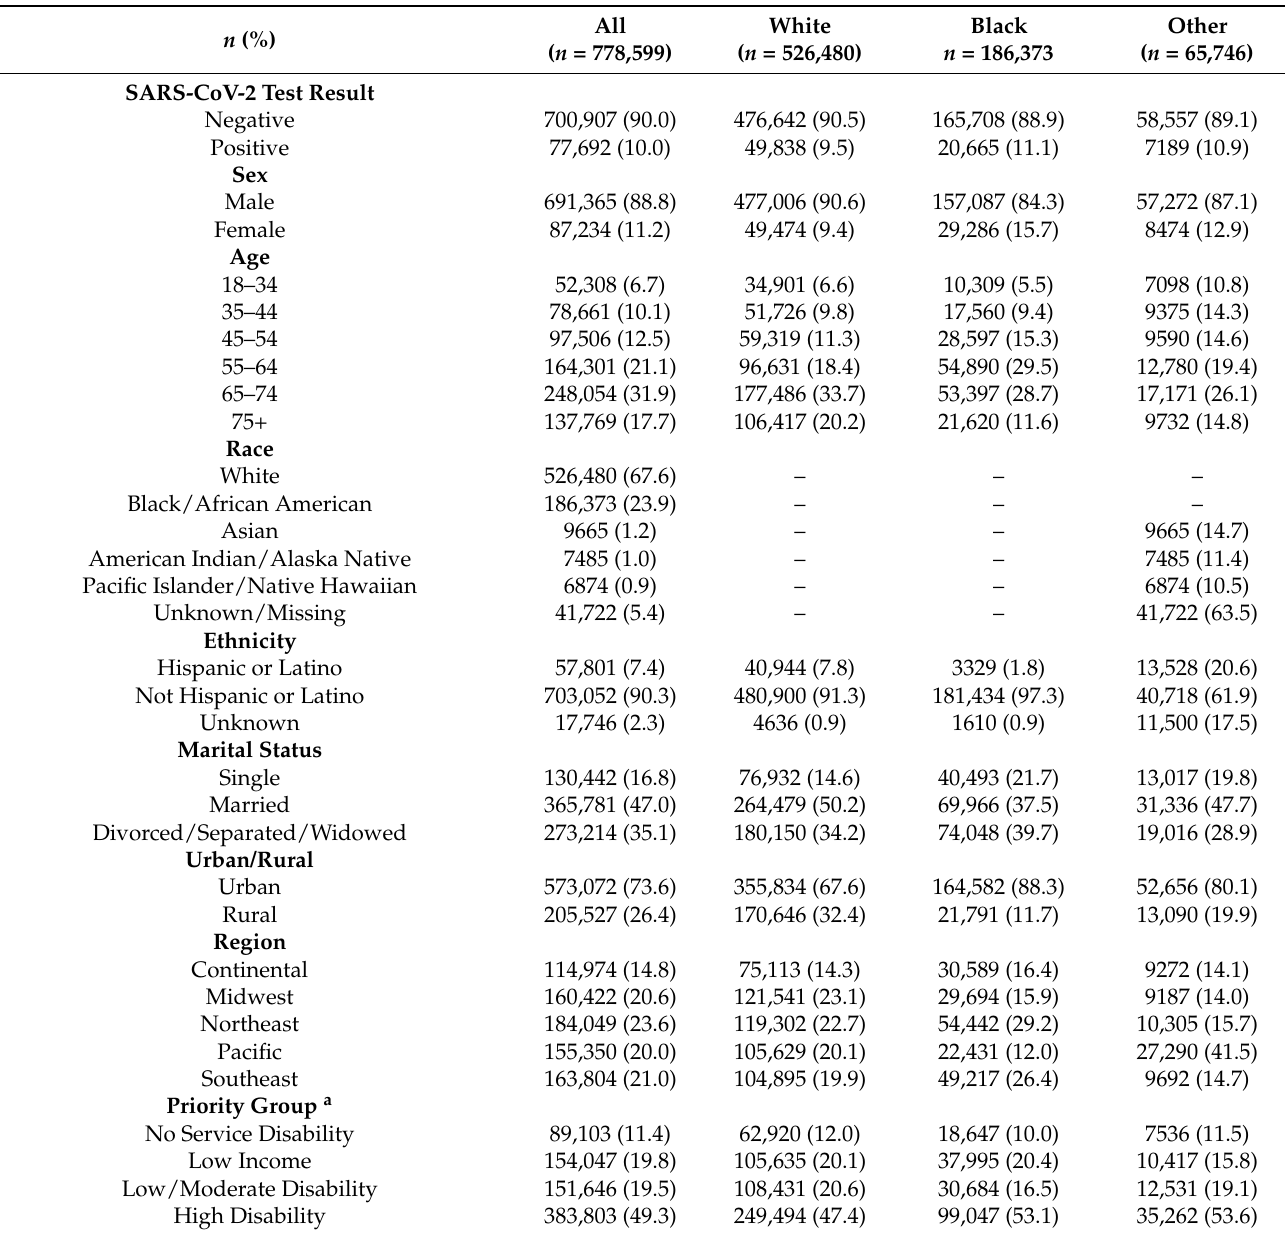
Table 1. Individual and county-level demographic and social determinants of health characteristics among U.S.